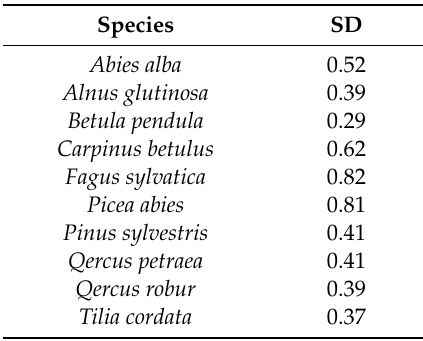
Table 4. Standard deviation (SD) in the mean flowering index of major forest trees in Germany during the period